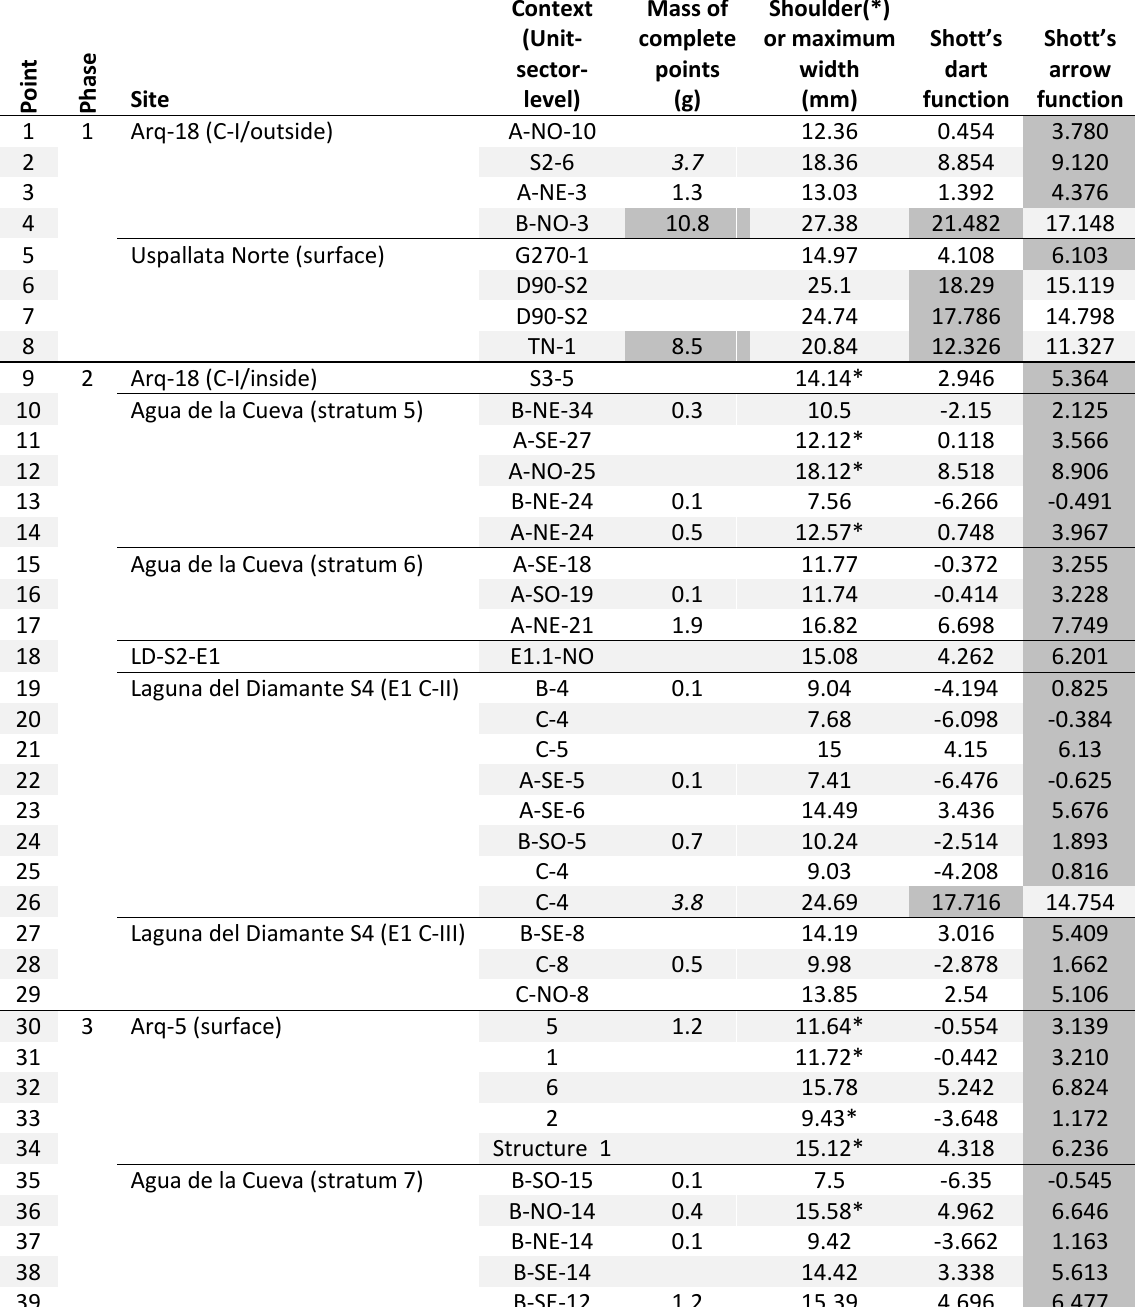
Table 2. Measurements and function scores for projectile points, sorted by phase. The bold function score indicates the higher value and hence the dart or arrow classification. The two masses in bold fall into Fenenga’s large class of points; the two masses in italics are intermediate between the small and large size